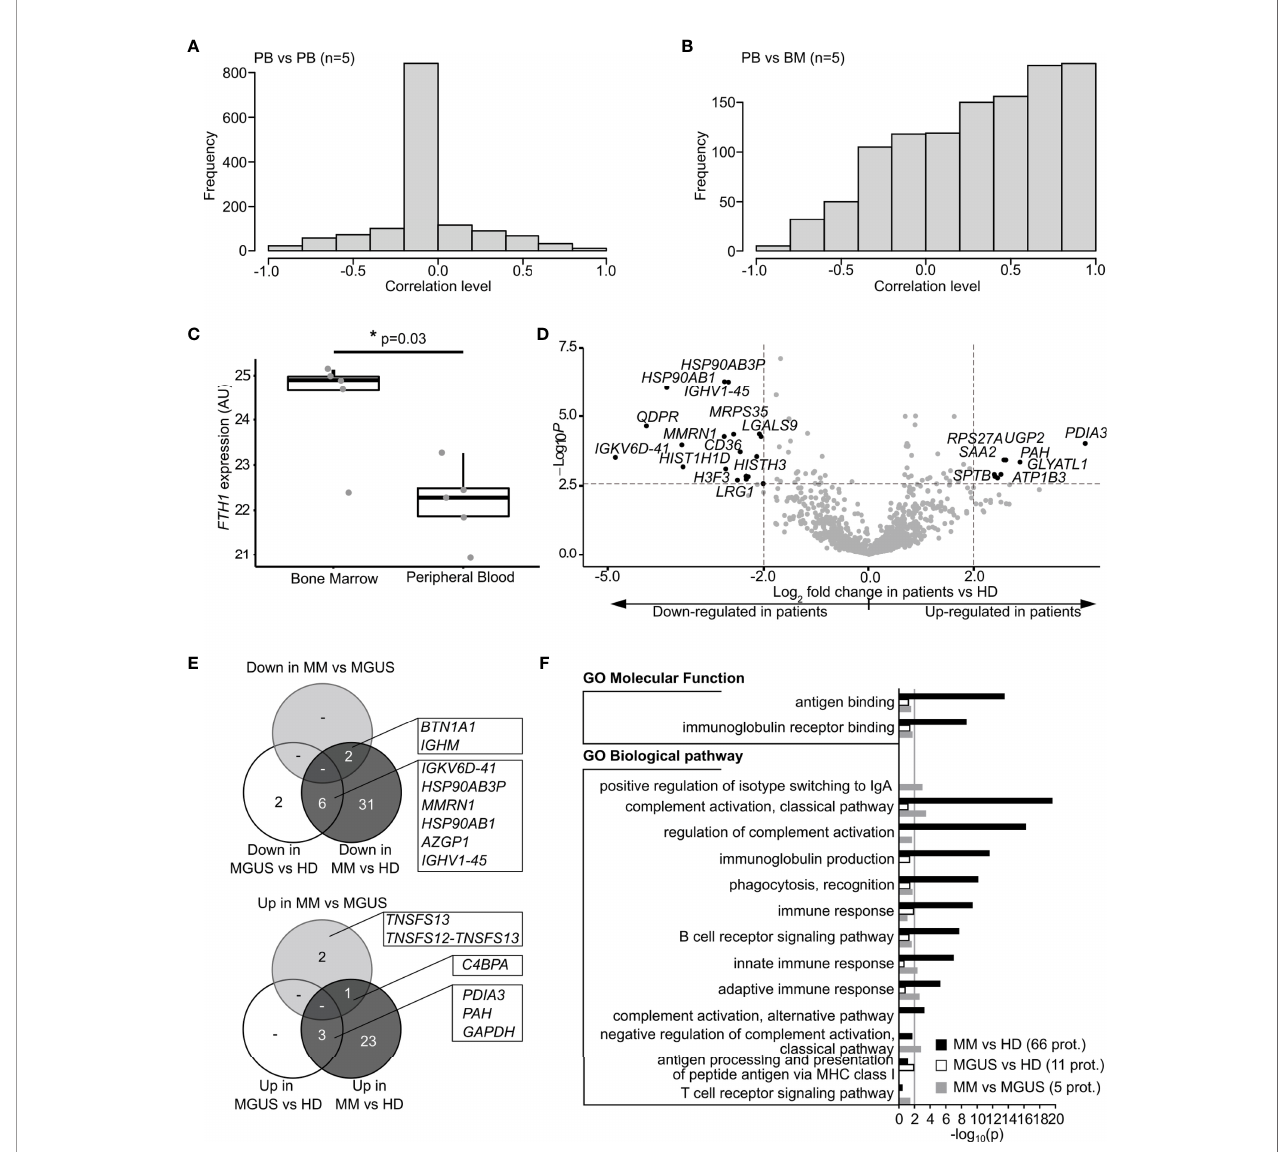
FIGURE 2 | Characterization of proteins identi fi ed in EV from peripheral blood and bone marrow according to the diagnostic group. (A) Correlations between PB- matched samples from 5 pairs of patients (10 samples). Samples were matched considering the myeloma status at sample collection, existence of extramedullary disease, R-ISS status, number of previous treatment lines, and depth of response to treatment. The correlation for each protein is stored on as hyperbolic arctan (correlation). In this case, the correlations are equally distributed between positive and negative values but present a mode around 0. In the “ limma ” package, the consensus correlation is computed by discarding the most extreme outliers, averaging the remainder on the hyperbolic arctan scale, and then transforming back to a correlation. (B) Correlations between PB and BM samples collected from the same 5 patients at matched time points (10 samples). Correlation was computed as described in (A) . For this case, the correlations are mainly positive and have a mode around 0.8. (C) Boxplot of iBAQ values obtained for Ferritin Heavy Chain 1 ( FTH1 ). Matched PB and BM samples from 5 patients were compared (10 samples). The LC-MS/MS data were quanti fi ed by three different computational methods to ensure a consistent computational analysis: spectral counting, iBAQ quantitation based on ion counts, and iBAQ quanti fi cation based on ion counts using the match between runs. For all three analyses, FTH1 was signi fi cantly more abundant in BM samples, even after correction for multiple testing. (D) Volcano plot representation of differentially expressed proteins between all monoclonal gammopathy patients analyzed together and HD: differential expression of proteins above the horizontal line is signi fi cant with p-adjusted <0.05; differential expression of proteins outside the vertical dotted lines indicates a 2-logarithimical fold change (log 2 FC) <-2 or >2. (E) Venn diagrams representing signi fi cant differentially expressed proteins of downregulated (top panel) and upregulated (bottom panel) proteins in peripheral blood-derived EV between patient subgroups (MM and MGUS) and HD. Proteins with overlap between the 3 comparisons (MM vs. MGUS, MGUS vs. HD, and MM vs. HD) are described in boxes. (F) Functional enrichment analysis of differentially expressed proteins using the FunRich software. Enrichment of immune- related molecular function and biological process was ranked for all deregulated proteins in MGUS and MM patient subgroups compared to healthy donors ’ EV. PB, peripheral blood; R-ISS, revised international staging system; BM, bone marrow; AU, arbitrary unit; HD, healthy donor; MGUS, monoclonal gammopathy of uncertain signi fi cance; MM, multiple myeloma; EV, extracellular vesicle; prot,